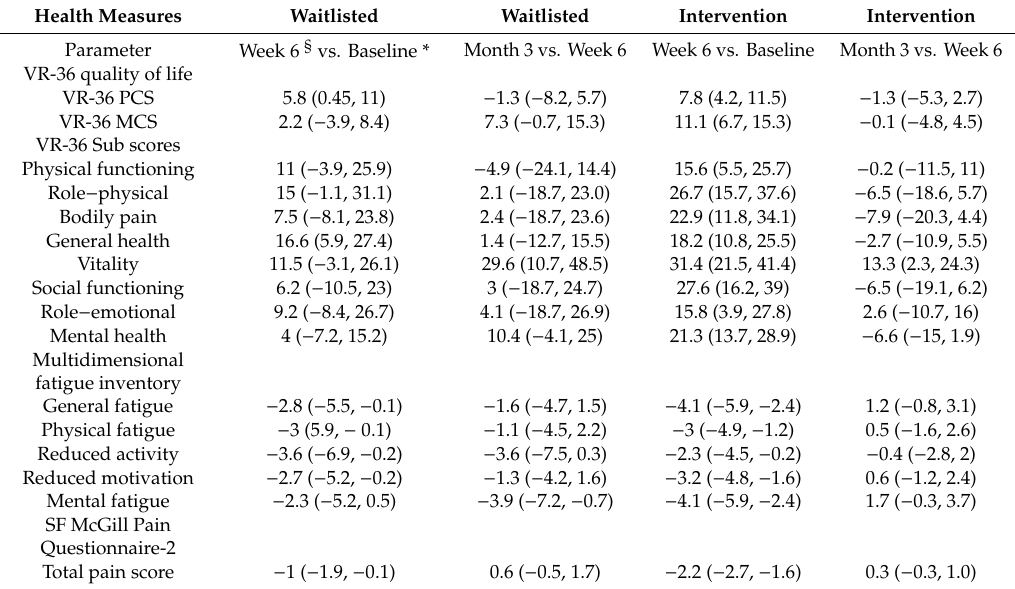
Table 3. Estimated Magnitude of Change Over Time to 3 months By Group #